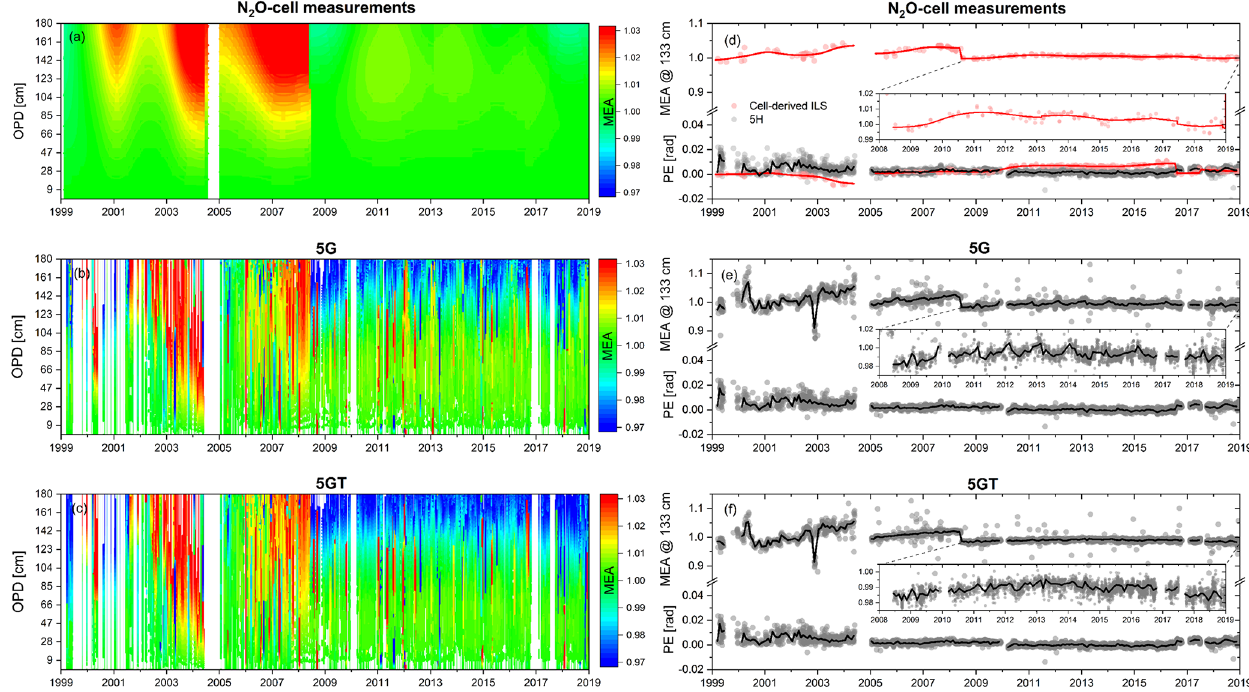
Figure 3. Time series of the MEA as a function of the OPD from 1999 to 2018 evaluated from (a) N 2 O cell measurements, (b, c) O 3 retrievals (5G and 5GT). Panels (d) , (e) , and (f) are the same as (a) , (b) , and (c) but for the MEA and PE at an OPD of 133cm. The PE values retrieved from the 5H set-up are also included in (d) . Note that for set-ups 5G, 5GT, 5H, and 5HT the retrieved PE is constant throughout the whole OPD